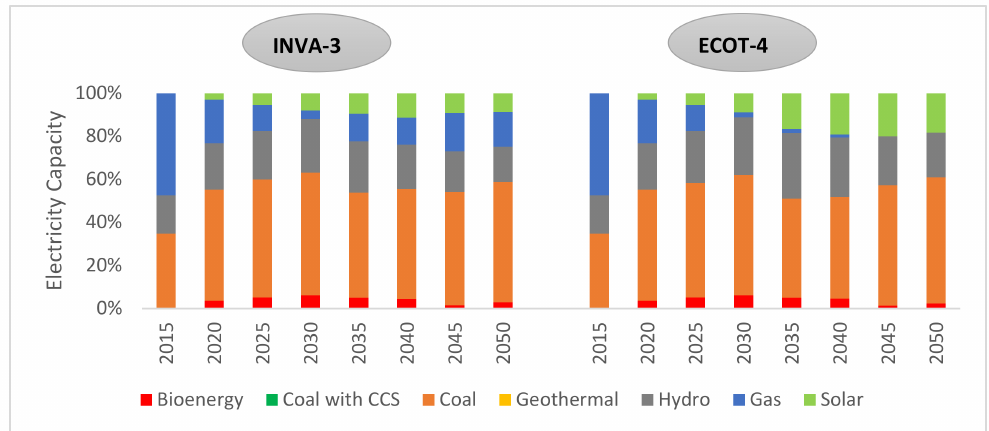
Figure 4. Electricity capacity by technology under renewable energy policy